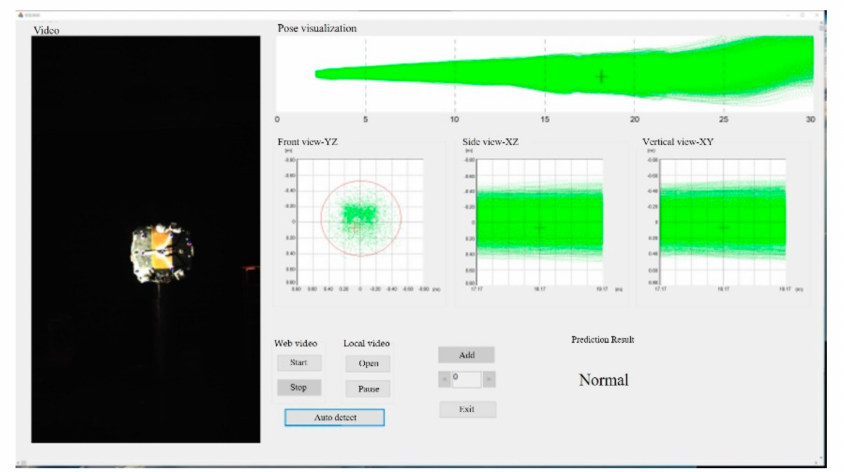
Figure 8. Data display and human–computer interaction interface.